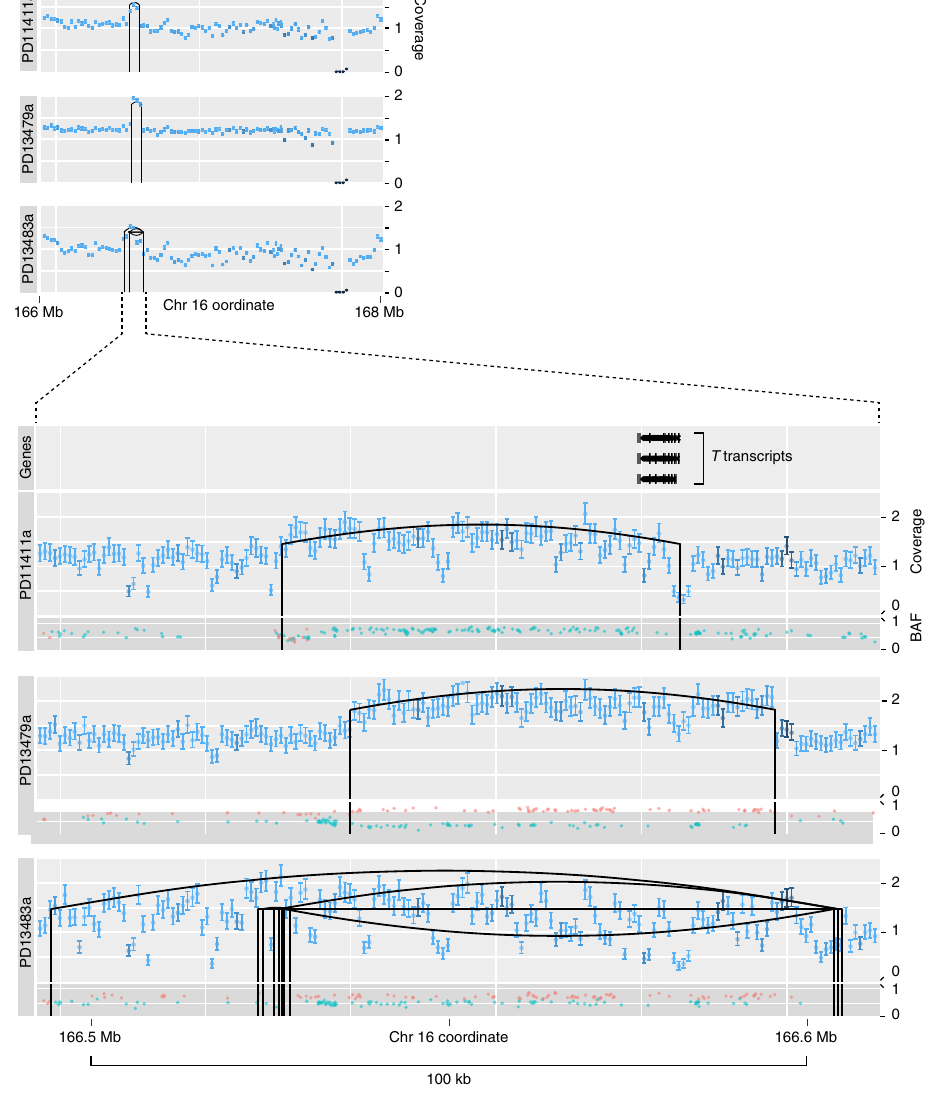
Fig. 2 T duplications in 11 chordoma genomes. Coverage tracks: for each tumour, the coverage of the T locus is shown over a 2 Mb window (upper panel) and a 100 kb window (lower panel). X axis: genomic position. Y axis: coverage (unit: number of 5 ′ ends of fragments in a bin/(length of bin × reads for sample) × 3 × 10 9 ). The error bars show the 95% con fi dence interval for the true mean coverage in each coverage bin. The colour coding of the error bars expresses the average mapping score in each bin (light = high; dark = low mapping score). Rearrangements are displayed as vertical black lines at the breakpoints connected by an upward arc for tandem duplications, a downward arc for deletions, and a straight line for inversions. BAF (B-allele frequency) track: the BAF tracks show the allele frequencies of heterozygous SNPs. Allele frequencies were plotted in a colour corresponding to their inferred parental chromosome, as determined by comparison to imputed haplotype blocks provided by the 1000 genomes project. X axis: genomic position. Y axis: